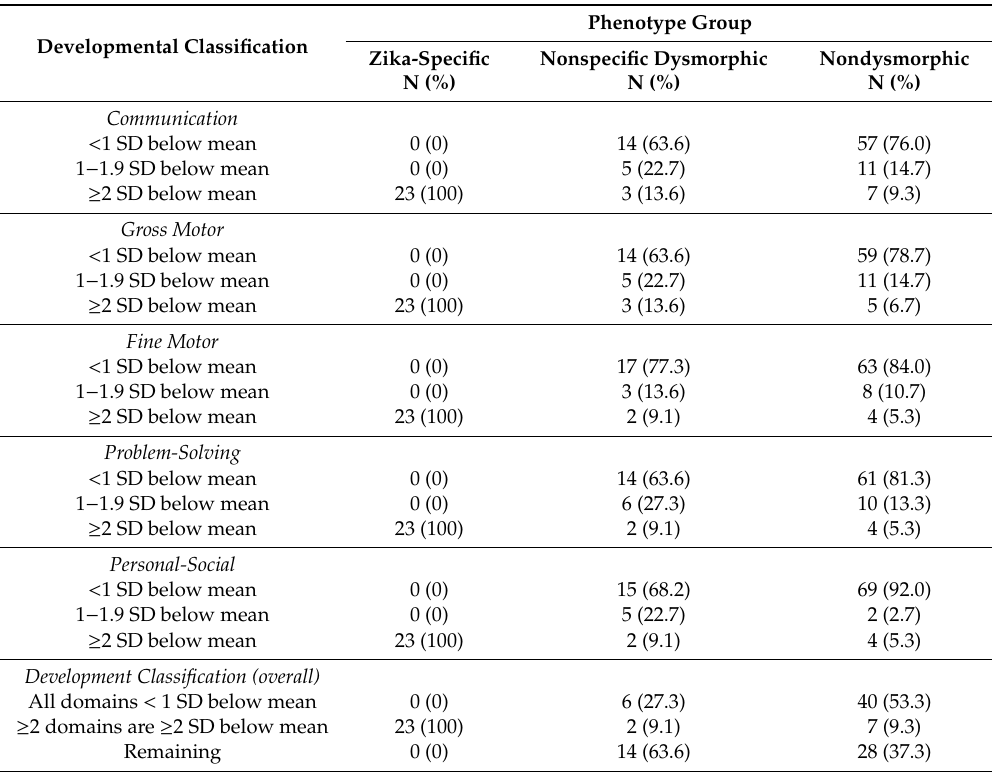
Table 2. Developmental delay by phenotype group among children with anthropometric and / or laboratory evidence suggestive of possible congenital zika infection, from birth to approximately age 24 months, Zika Outcomes and Development in Infants and Children (ZODIAC) investigation, 2017.